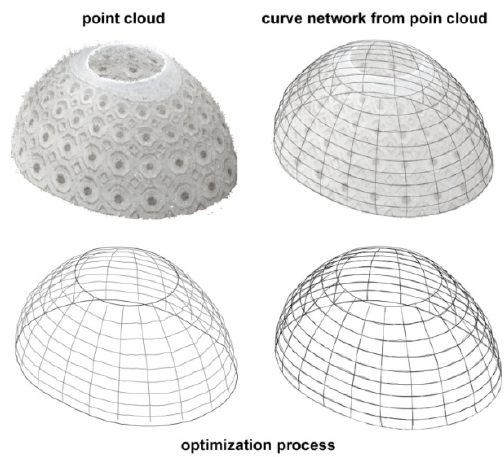
Figure 15. Dome of S. Giovanni Maggiore: ideal model from point